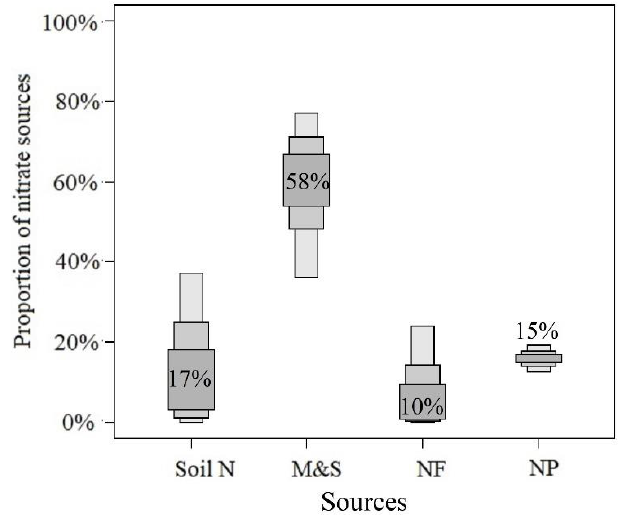
Figure 7. The proportional contribution of potential sources of nitrate in the water of the nearshore area in the fall, including soil N, manure and sewage (M&S), nitrogen fertiliser (NF) and nitrate in precipitation (NP).